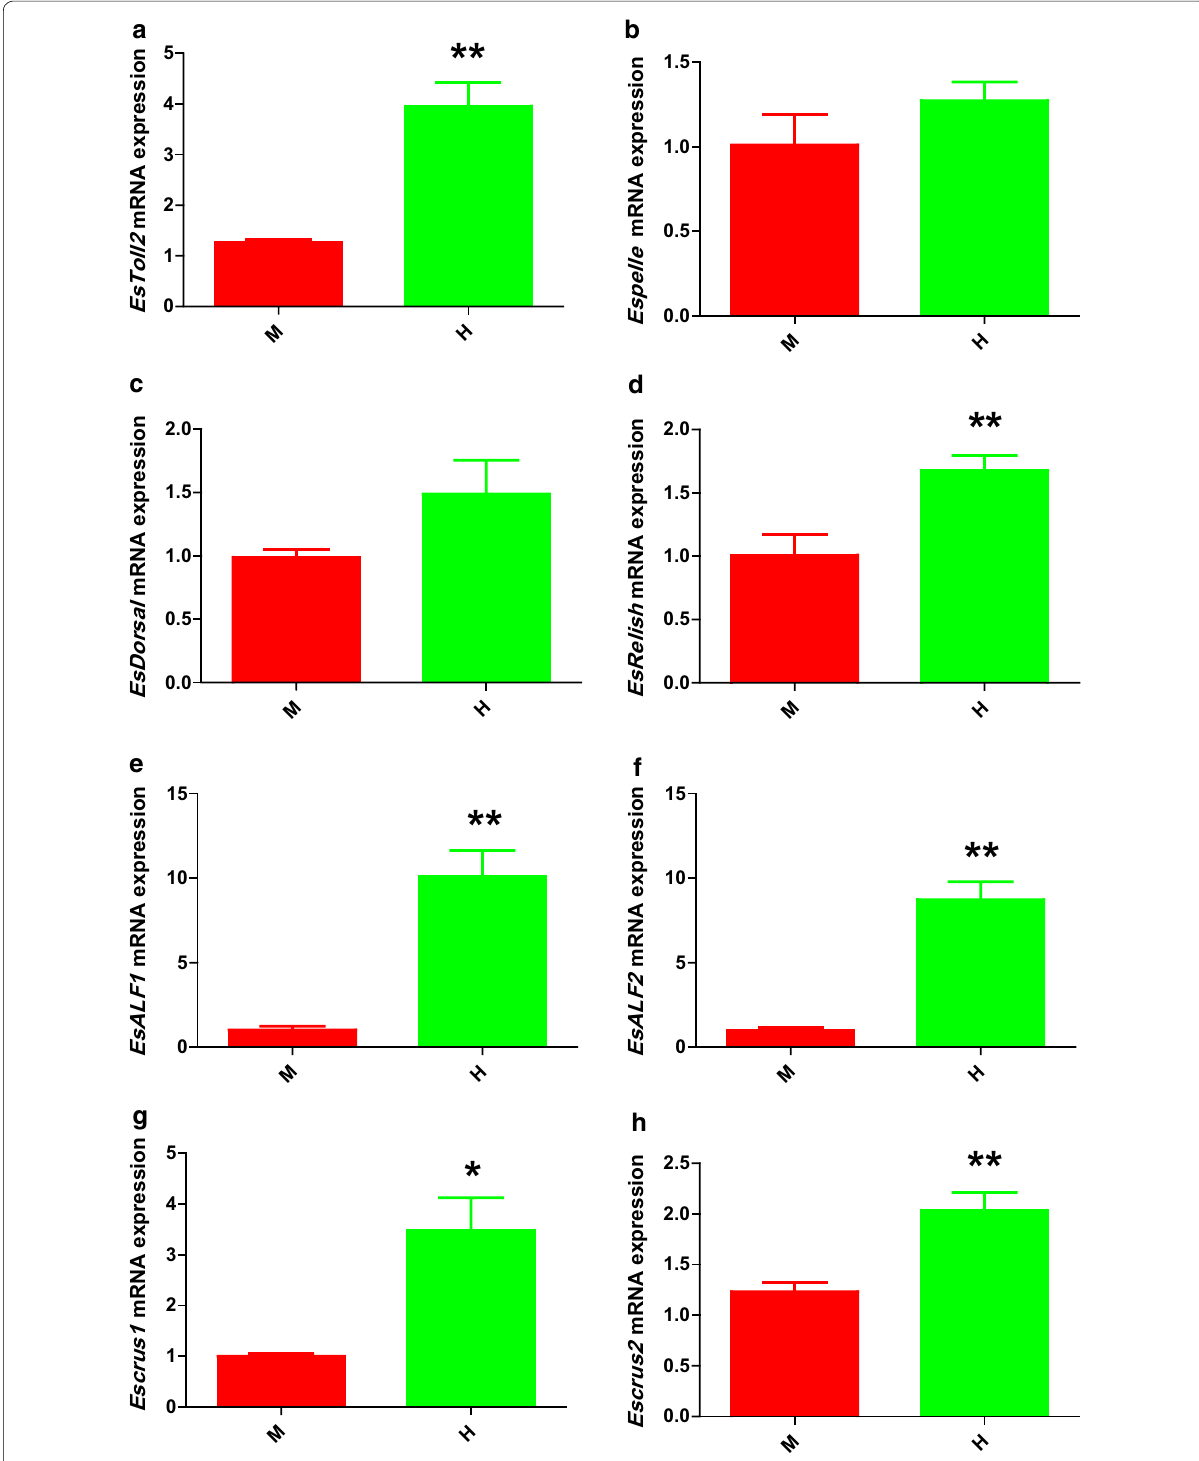
Fig. 4 Comparative analysis on gut immune gene expression (relative to Es - β - Actin ) in the intestinal tract of E. sinensis (mean relative expression profile of 8 immune-related genes ( EsToll2 , EsPelle , EsDorsal , EsRelish , EsALF1 , EsALF2 , EsCrus1 , EsCrus2 ) in crab midgut and the hindgut. M: midgut (red), H: hindgut (green). 0.01 < P